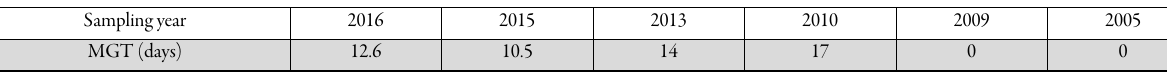
Fig. 2. Germination percentages, after 30 days of incubation, of Thalictrum maritimum seeds sampled in the indicated years and mechanically scarified before plating in the Petri dishes Table 1. Effect of seed storage time on germination velocity, expressed as ‘mean germination time’ (MGT), in Thalictrum